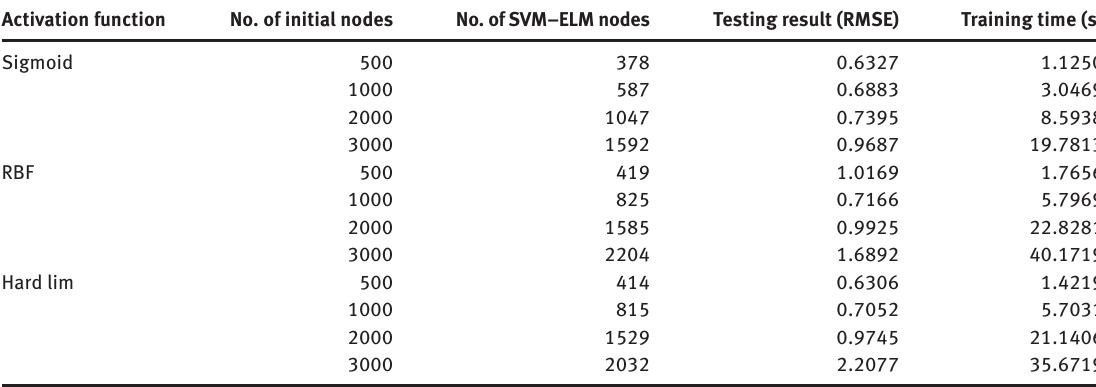
Table 2: Investigation of the Effect of Initial Number of Nodes on the Final SVM–ELM Network Architecture Complexity and Testing Results.